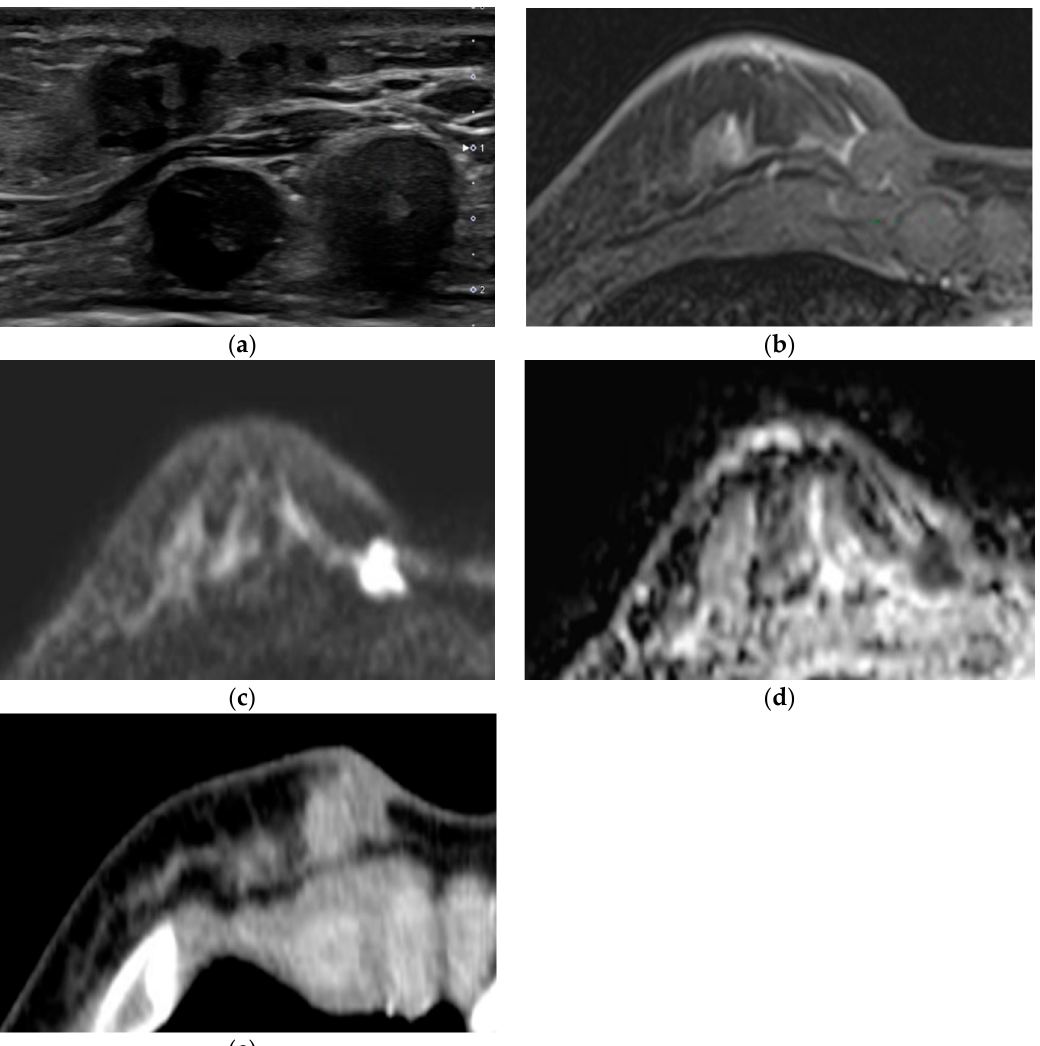
Figure 2. A 42-year-old woman with palpable mass at breast periphery. ( a ) In the ultrasound, a 2.3 cm irregular hypoechoic mass was detected in the palpable site of the right breast at the 4-o’ clock periphery and confirmed as invasive ductal carcinoma by core needle biopsy. ( b ) No discernible enhancing lesion at the correlating site in the early phase of dynamic contrast-enhanced T1WI. This palpable mass showed definite diffusion restriction with an ADC value of 0.68 × 10 − 3 in DWI b = 1000 ( c ), ADC map ( d ), and homogeneous enhancement in contrast-enhanced chest CT in the supine position ( e ).